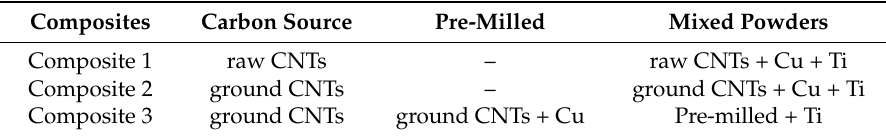
Table 1. Components of mixed powders for different composites. CNT: carbon